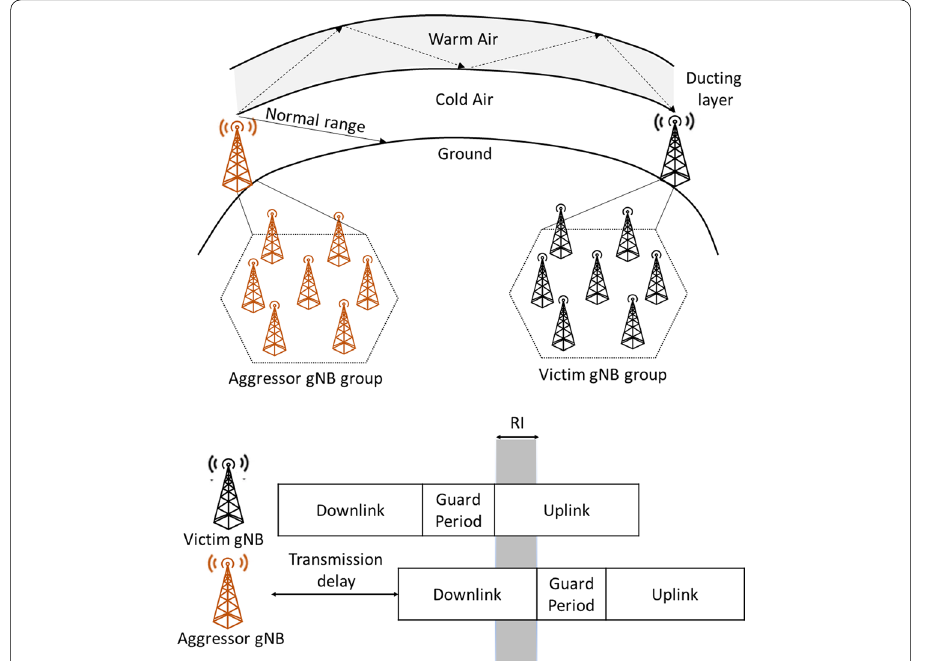
Fig. 1 Illustration of the remote interference (RI) problem stemming from the atmospheric ducting